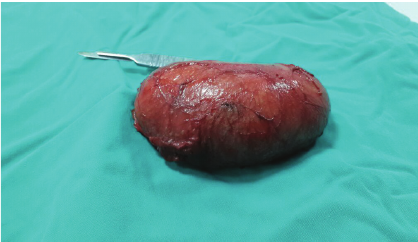
Figure 3: Gross macroscopic pathologic specimen of vulvar cyst.